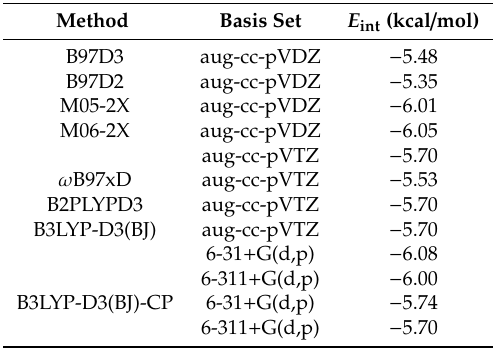
Table 2. Interaction energies of 1Py-CH using several B3LYP methods against high-level DFT methods with aug-cc-pVDZ and aug-cc-pVTZ basis